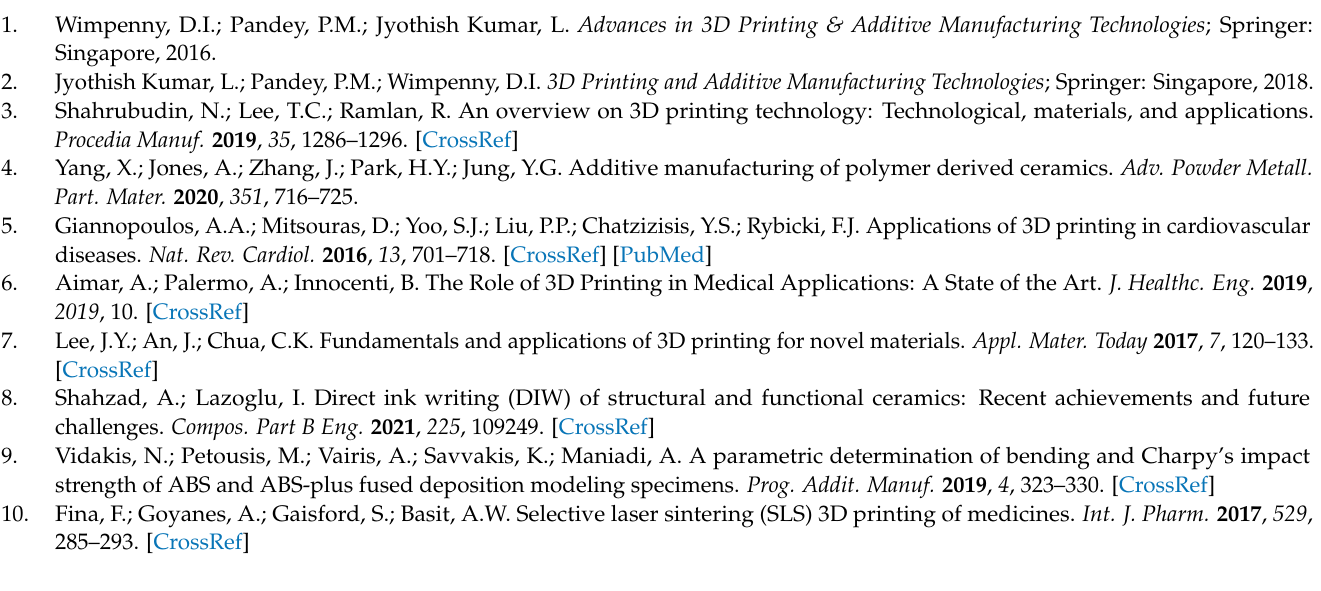
Powder, (H) Biomed Clear with 1 wt.% CNF and 1 wt.% Antibacterial Powder. Arrows indicate a phase change in the material. Figure S2: AFM measurements: (A) AFM setup employed in this work, (B) Biomed Clear pure resin; (C) Biomed Clear 1 wt.% CNF, (D) Biomed Clear 1.0 wt.% Cu, (E) Biomed Clear 1 wt.% CNF and 1 wt.% Cu, (F) Biomed Clear 1 wt.% Cu 2 O (G) Biomed Clear 1 wt.% CNF and 1 wt.% Cu 2 O, (H) Biomed Clear 1 wt.% Antibacterial Powder, (I) Biomed Clear 1 wt.% CNF and 1 wt.% Antibacterial Powder. Figure S3: (A) Toughness calculated (MJ/m3) and deviation for all materials (B) Impact strength (kJ/m2) and deviation for all materials (C) Vickers-microhardness (HV) and deviation for all materials. Figure S4: (A) Typical gram-negative E. coli morphology and captures of Petri dishes, and related inhibition zones measurements of the nanocomposites: (B) Pure Biomed Clear, (C) Biomed Clear 1 wt.% CNF, (D) Biomed Clear 1 wt.% Cu, (E) Biomed Clear 1 wt.% CNF and 1 wt.% Cu, (F) Biomed Clear 1 wt.% Cu 2 O, (G) Biomed Clear 1 wt.% CNF and 1 wt.% Cu 2 O, Powder. Figure S5: (A) Typical gram-positive S. Aureus morphology and captures of Petri dishes, and related inhibition zones measurements of the nanocomposites: (B) Pure Biomed Clear, (C) Biomed Clear 1 wt.% CNF, (D) Biomed Clear 1 wt.% Cu, (E) Biomed Clear 1 wt.% CNF and 1 wt.% Cu, (F) Biomed Clear 1 wt.% Cu 2 O, (G) Biomed Clear 1 wt.% CNF and 1 wt.% Cu 2 O, (H) Biomed Clear 1 wt.% Antibacterial Powder, (I) Biomed Clear 1 wt.% CNF and 1 wt.% Antibacterial